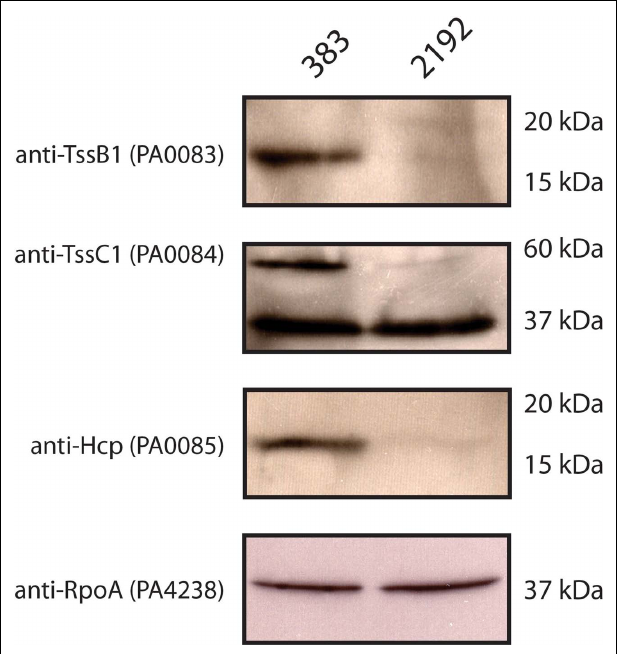
FIGURE 4 |Western blot analysis ofType 6 secretion system (T6SS) proteins in strains 383 and 2192. L broth cultures were inoculated with the strains 383 and 2192 and grow at 37˚C into log phase (OD 600 O.5). Log phase whole cells suspended in L broth were added to equal volumes of 2 × Laemmli buffer and subjected to separation by 12% SDS-PAGE and electro-transferred to 0.2 μ m nitrocellulose membranes. Membranes were probed with the antibodies indicated. Molecular weight markers are indicated showing the relative migration of proteins detected. Shown is a representative of three independent experiments.